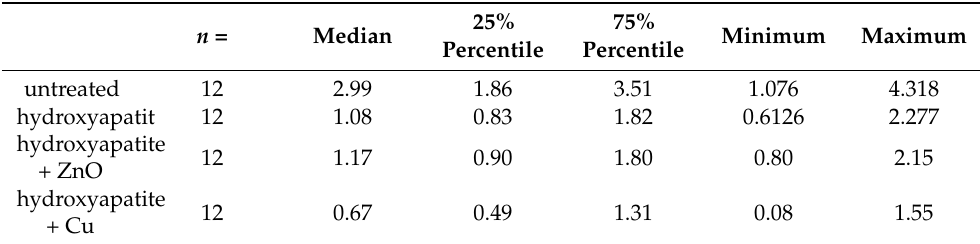
Table 3. Descriptive analysis (median, percentiles, minimum, and maximum) of HGF-1 green value after 24 h of cell cultivation measured in arbitrary